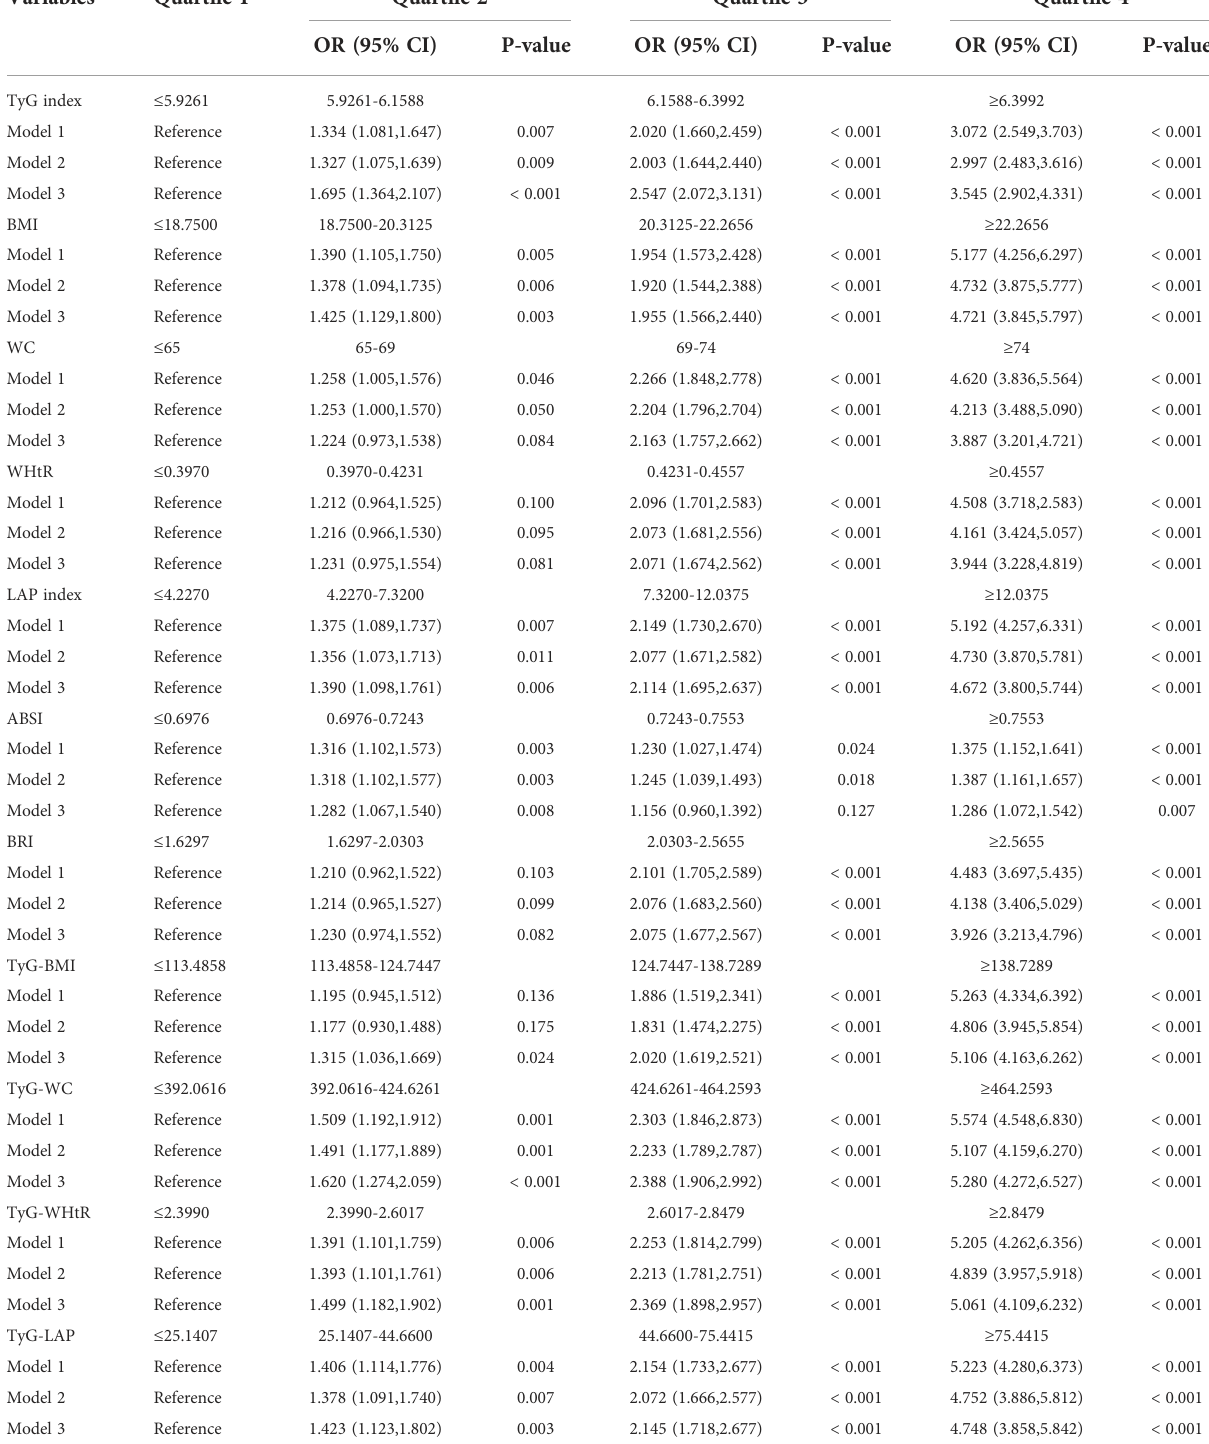
TABLE 3 Multivariate logistic regression of different indices for HUA